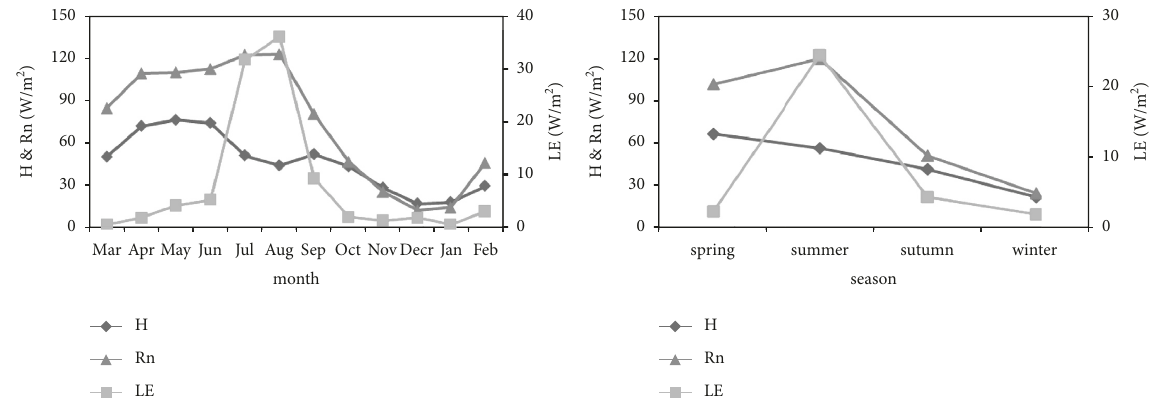
Figure 3: The monthly and seasonal mean variation characteristics of the sensible heat, latent heat, and net radiation